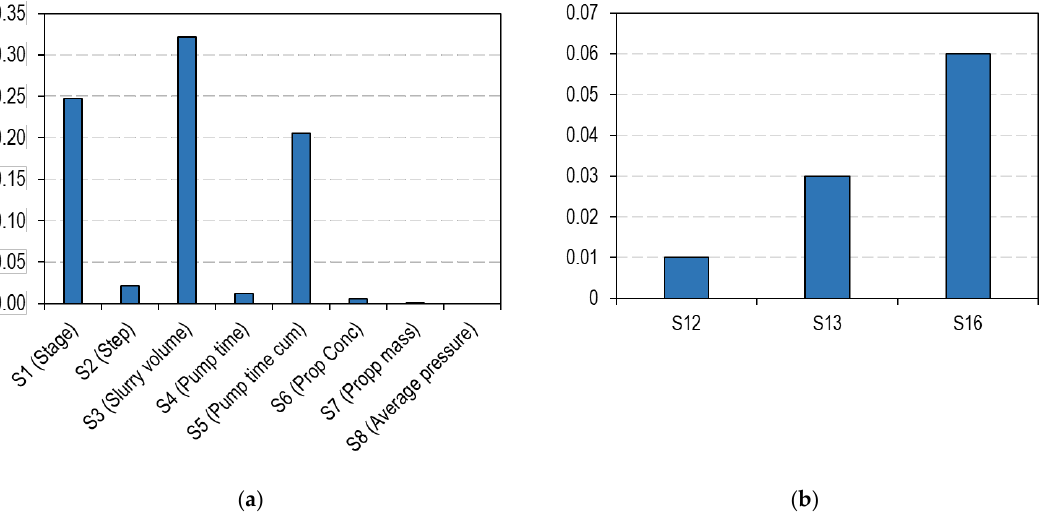
Figure 14. Dominant first- ( a ) and second-order ( b ) Sobol indices. The second-order terms correspond to the percentage of changes from simultaneous changes in the I and j variables.